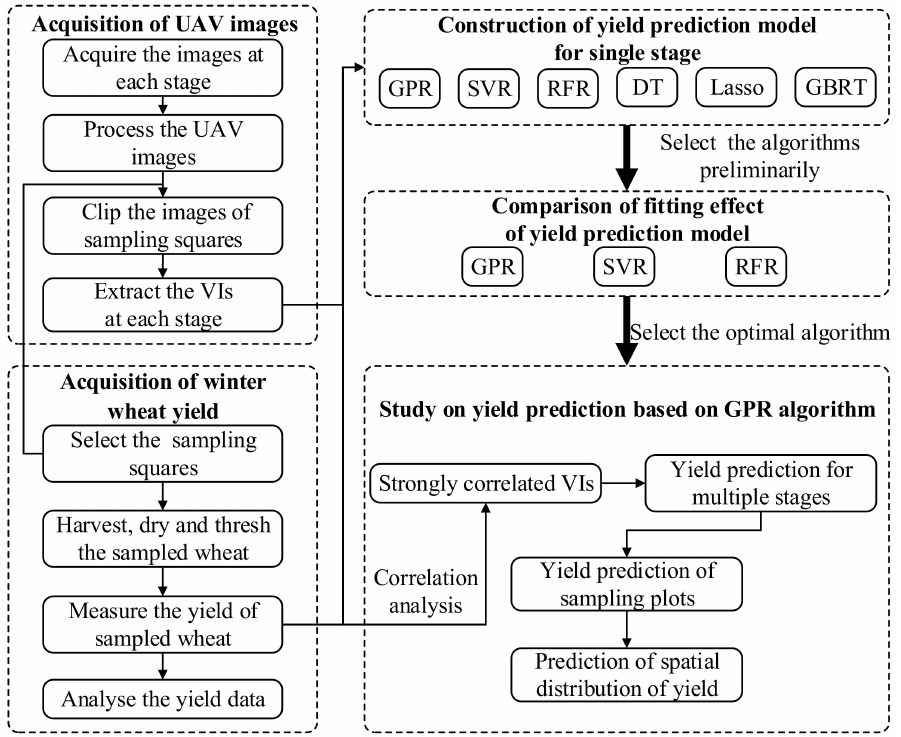
Figure 5. Flowchart of yield models construction in this